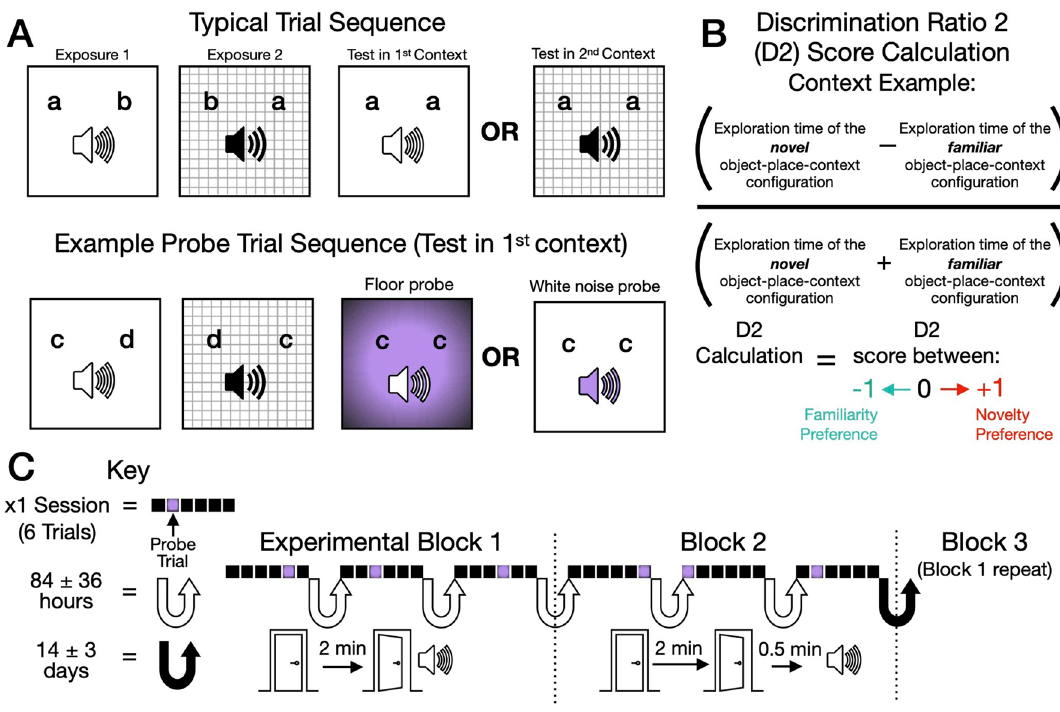
Figure 2. Methodology of trial types and experimental timeline. ( A ) Unexpected object-place-context task. Upper: ‘Contexts’ were comprised of tone-floor pairings. Typical trials: 2 exposure phases (far and middle left; letters denote objects). The test can be made in the 1st context (right-middle) or in the 2nd context (far-right). Exposure and test phases were 2 min, as were the interval between them and the next trial starting in a session. Lower: Example probe trial (test in the 1st context): Floors are replaced (right-middle; tones remain stable) or tones are replaced (far-right; floors remain stable). ( B ) Discrimination ratio 2 (D2) calculation (context example). For each animal, the context D2 score, recency D2 score and side bias was calculated individually for each trial and then averaged across all trials (in a given session/block) and finally across animals to give an average D2 score. We also separated trials occurring before/after probe trials for a given session, and averaged them across a block, creating a before/after probes context and recency average D2 score. This was